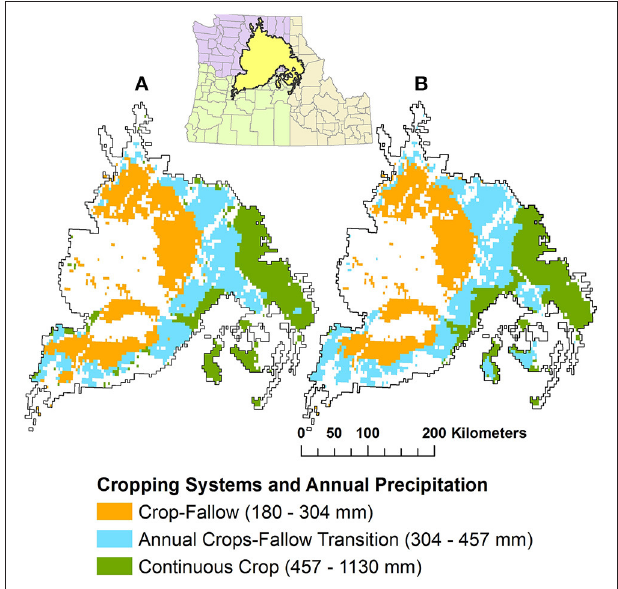
FIGURE 1 | Agroecological classes in the dryland region of the Inland Pacific Northwest based on (A) 5-year aggregated crop data layers, and (B) annual precipitation.